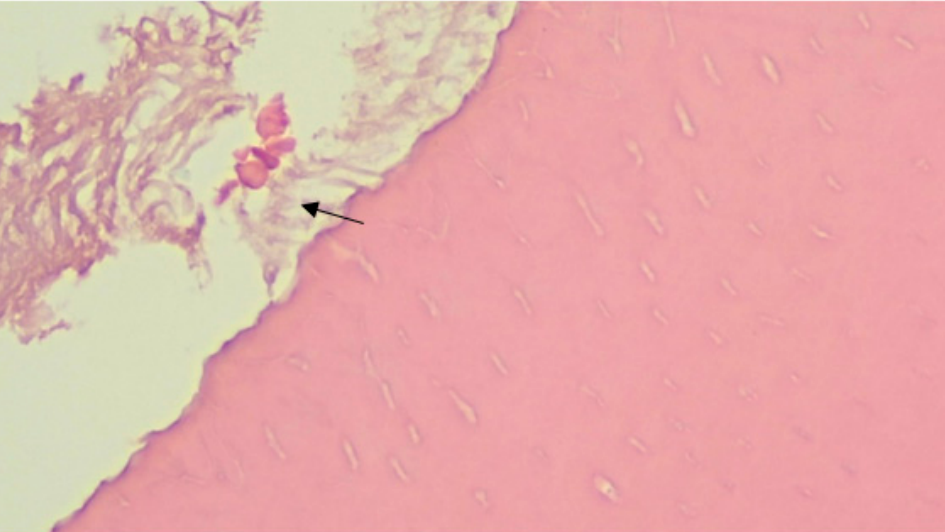
Figure 4. The focus of deep demineralization of tooth enamel in the control group (microscopic examination of the enamel in the area of the carious spot revealed changes in the crystals: a violation of the orientation of the crystals in the structure of hydroxyapatites, a change in the shape of the crystals, their size, and the appearance of crystals atypical for normal enamel. Staining with Ehrlich’s hematoxylin, in magnification × 200).